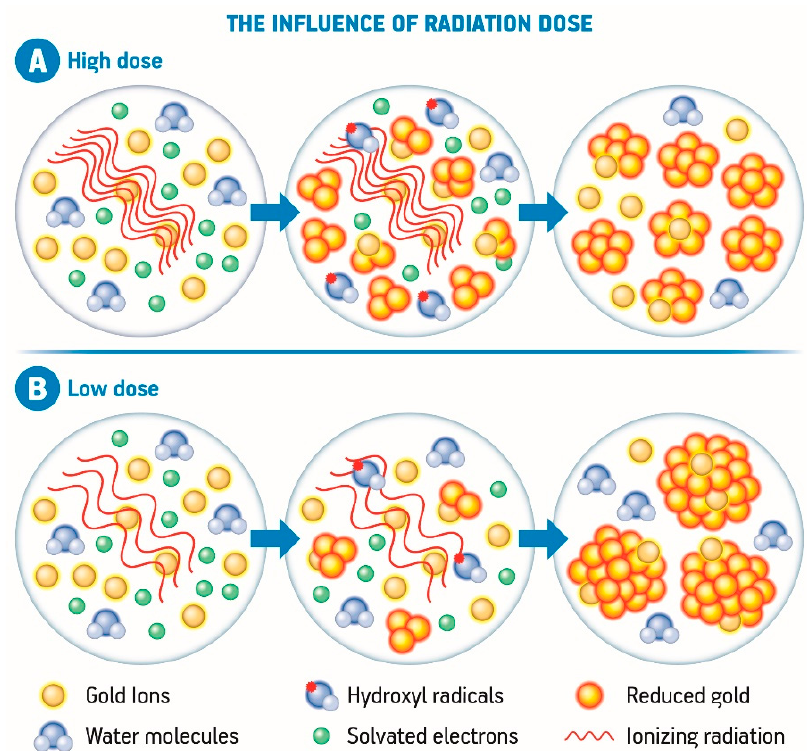
Figure 3. Representative scheme of the influence of high ( A ) and low radiation dose ( B ) over the nucleation and growth of gold nanoparticles generated by the radiolytic synthesis using high energy radiation.